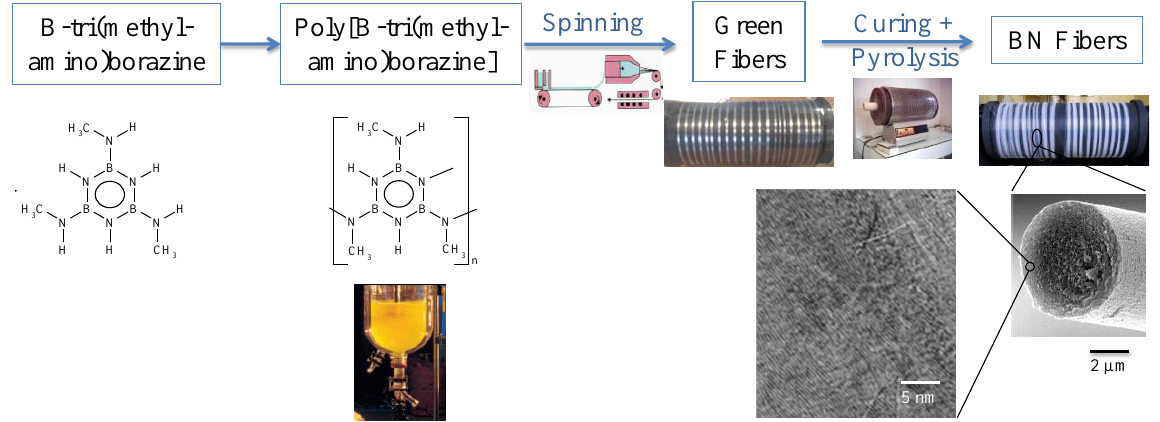
Figure 11. Overall process for preparing BN fibers: polymer melt-spinning, curing and pyrolysis.